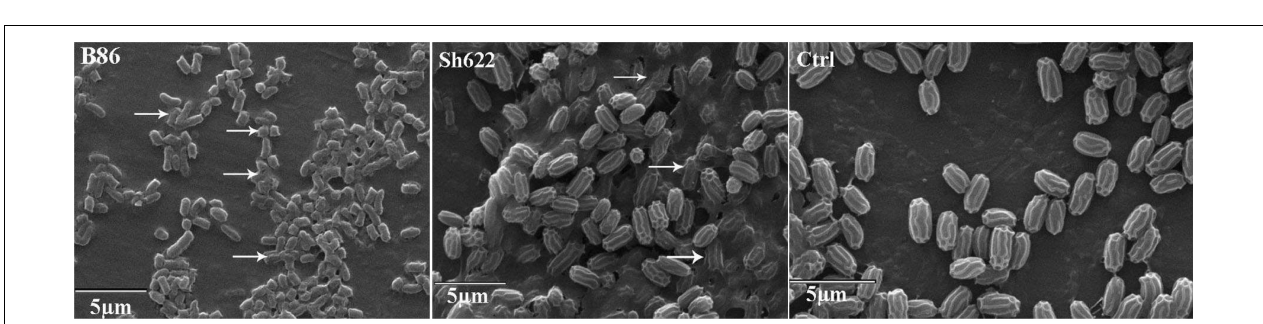
FIGURE 5 | Effects of VOCs produced by Streptomyces sp. B86 , Pantoea sp. Dez632 , Pseudomonas sp. Bt851, and Stenotrophomonas sp. Sh622 on (A) chemotaxis behavior toward root extract of sugar beet, (B) biofilm formation, and (C) root attachment of B. pumilus Isf19 compared to the non-treated control (Ctrl). Error bars indicate the SE of the three replicates. Different letters indicate significant differences ( P = 0.05).